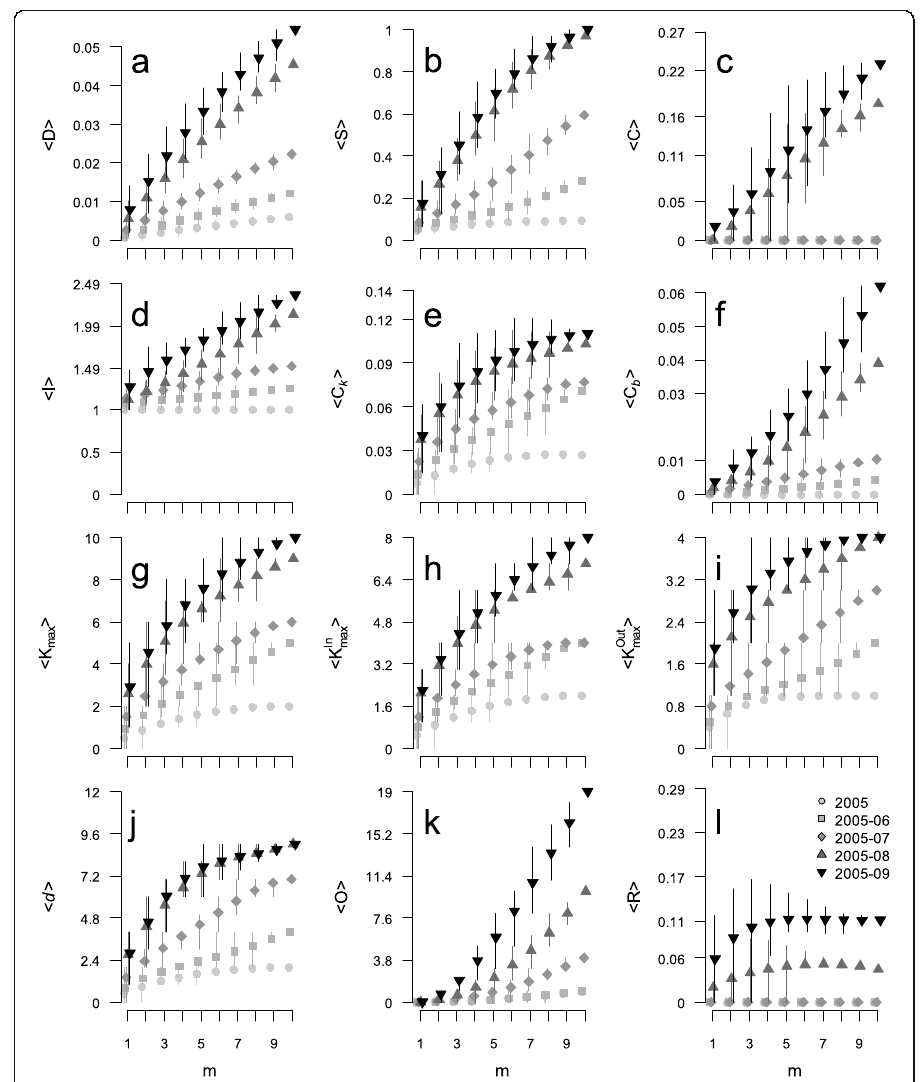
Fig. 4 Metrics calculated for the empirical multiplex using wildlife trafficking data for cumulative sequence of years. Metrics shown in each panel are: density ( a ), clustering coefficient ( b ), size of the largest component ( c ), average path length ( d ), centralizations by degree and betweenness ( e , f ), maximum degrees ( g - i ), network diameter ( d ), link overlapping ( e ), and reciprocity ( f ). Elements are slightly displaced in the x